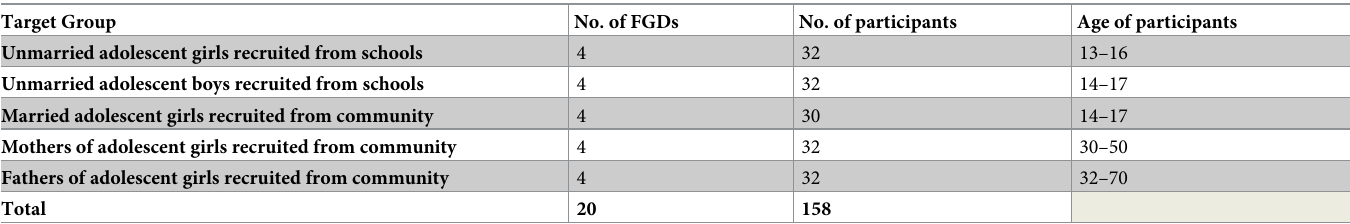
Table 1. Focus group discussion participants distribution.